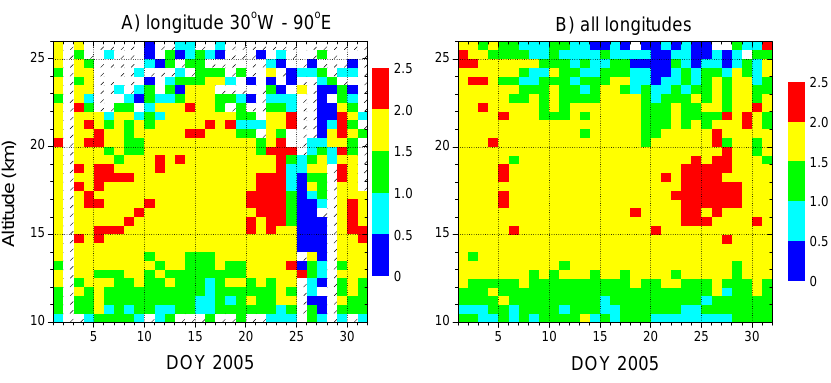
Fig. 5. ˚Angstrom exponent α calculated from SAGE III aerosol extinction as a function of altitude and time. Data were averaged over the longitudinal region 30 ◦ W–90 ◦ E (A) and all longitudes (B) in the Northern Polar region (latitude 66–73 ◦ ).